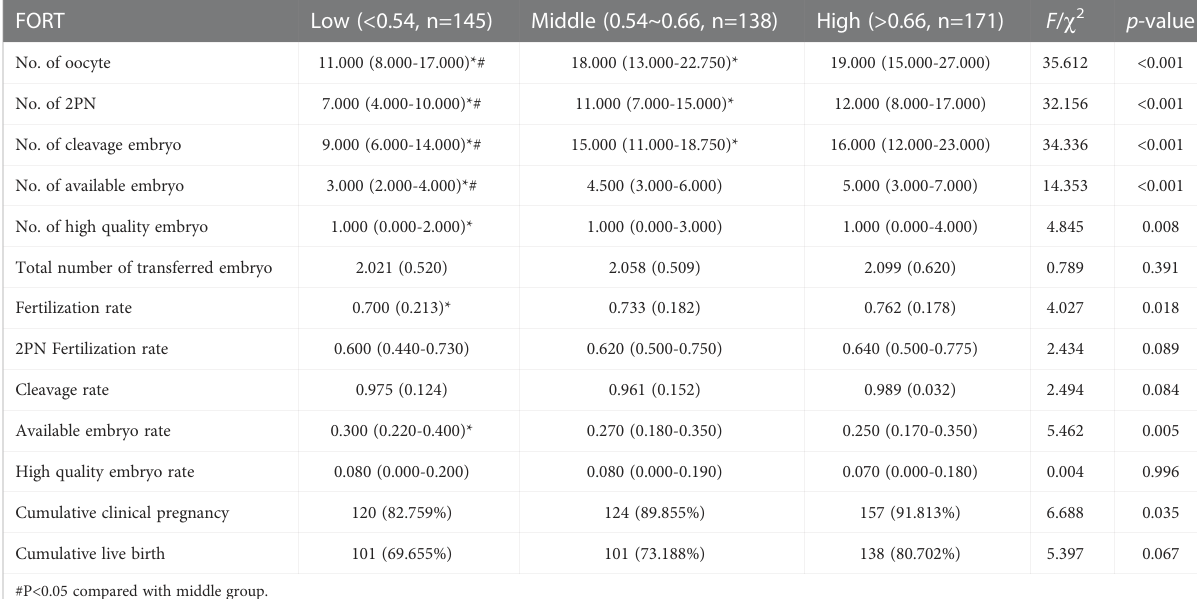
TABLE 2 Patient ’ s laboratory indicators and clinical outcomes.